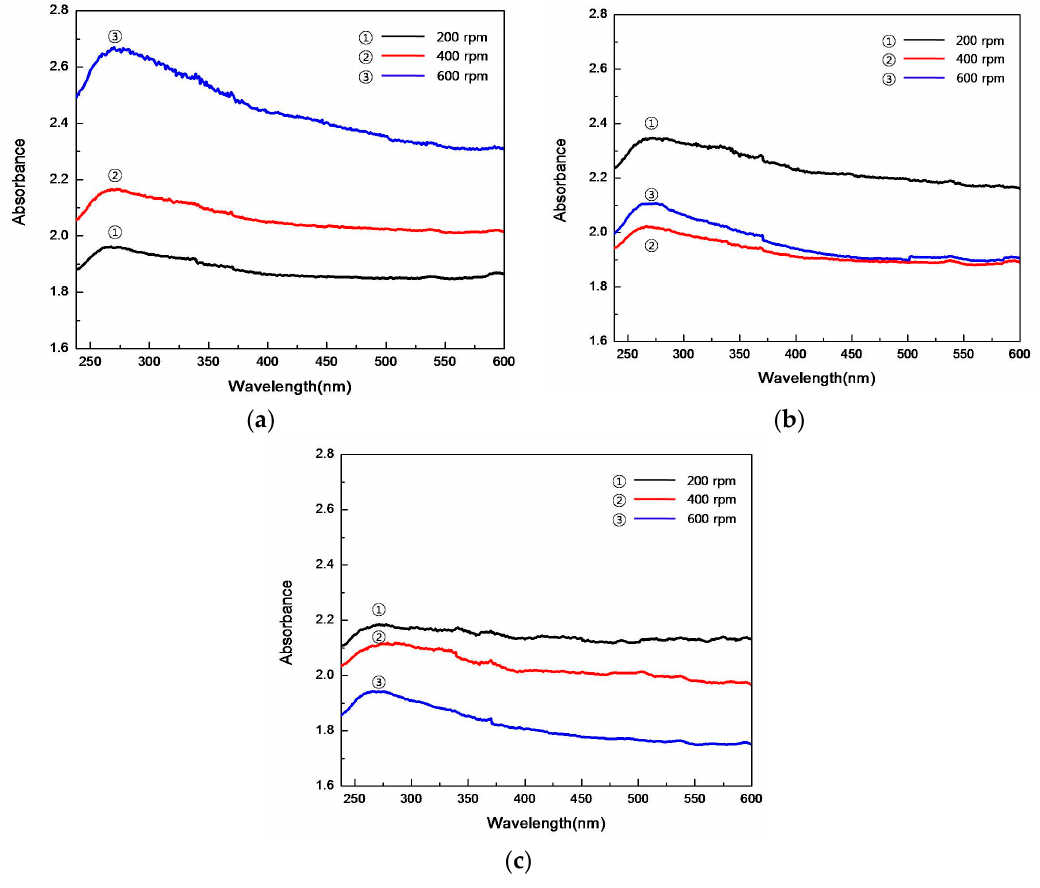
Figure 8. The graph of Absorbance measurement of the changes in the grinding time. ( a ) Grinding time: 30 min; ( b ) Grinding time: 60 min; ( c ) Grinding time: 90 min. time: 30 min; ( b ) Grinding time: 60 min; ( c ) Grinding time: 90